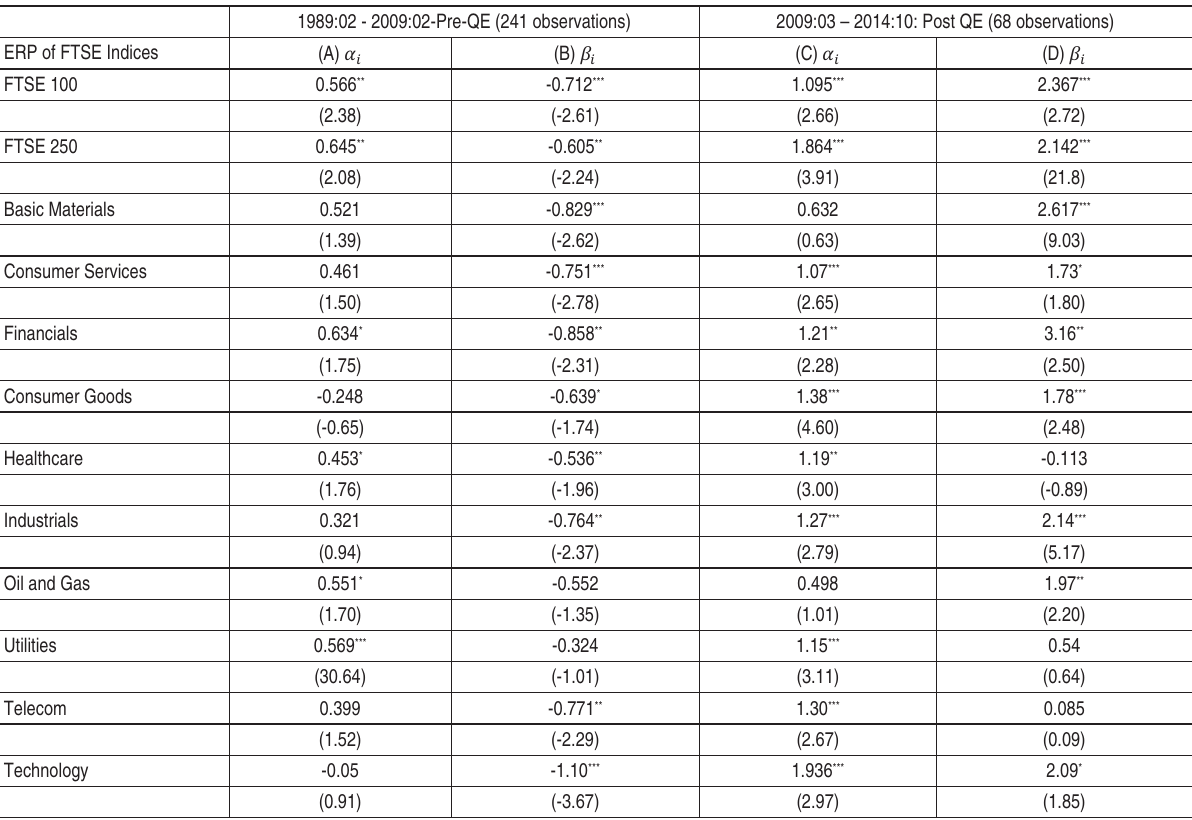
Table 4. The impact of structural monetary shocks on ERP: Pre and post quantitative easing 1989:02 - 2009:02-Pre-QE (241 observations) 2009:03 – 2014:10: Post QE (68 observations)